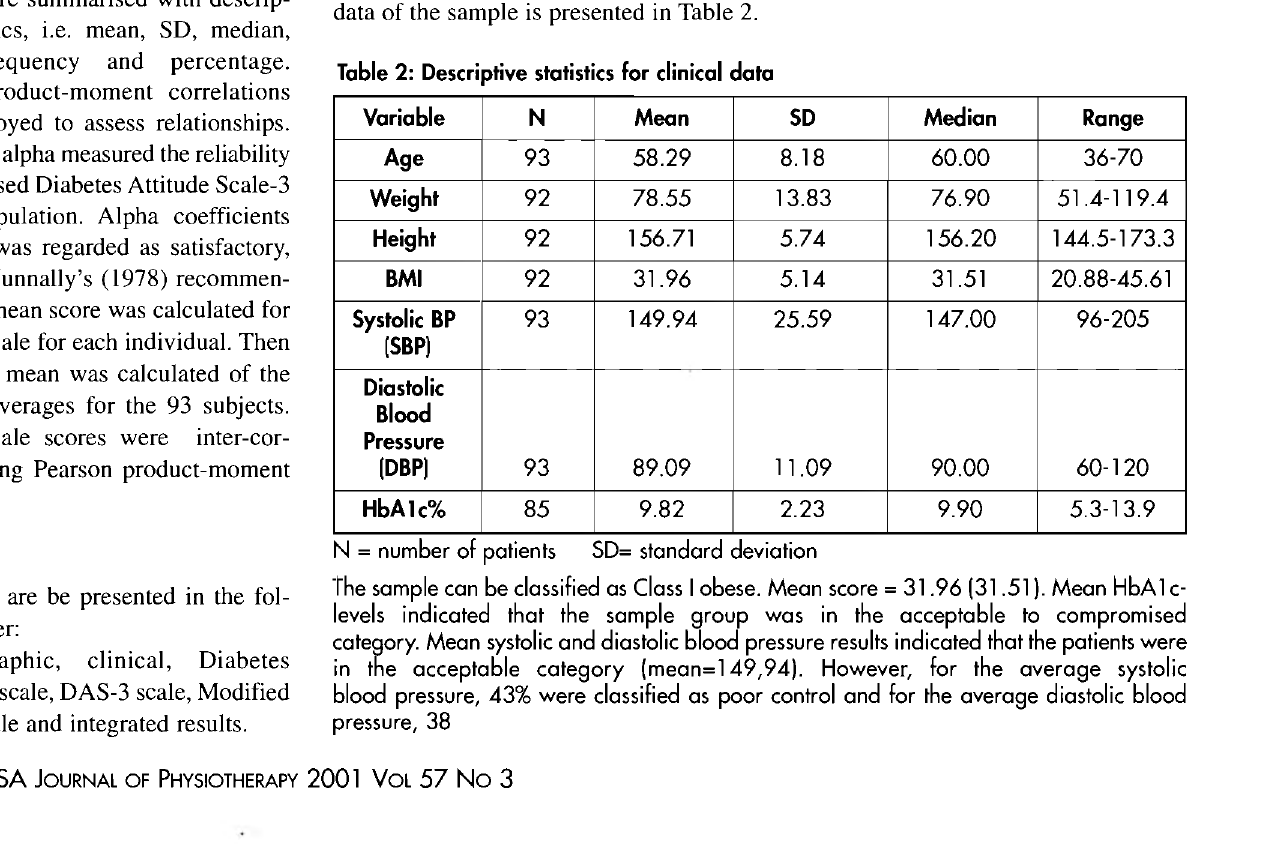
Table 2: Descriptive statistics for clinical